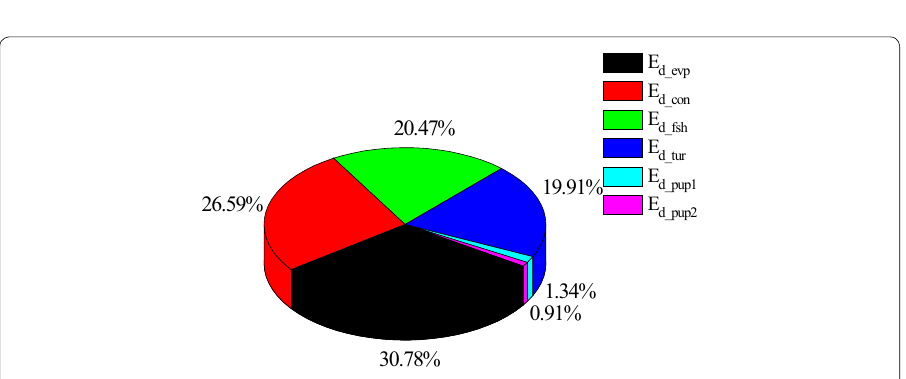
Fig. 5 E d distribution in BFC